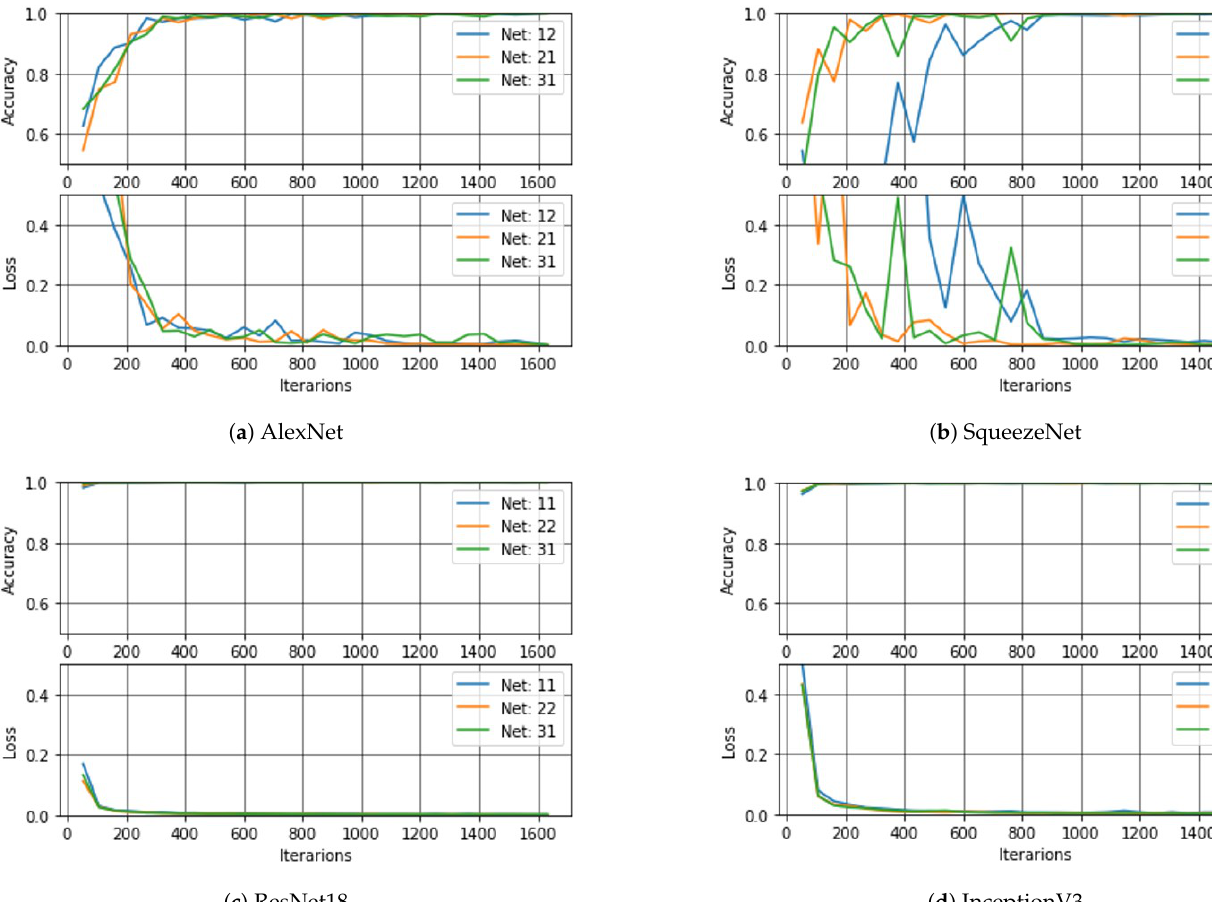
Figure 14. Convergence comparison for different TL-based models. The first index in each network corresponds to the dataset (i.e., 1 = DS1, 2 = DS2, 3 = DS3), while the second index corresponds to the freezing point (i.e., 1 = UF, 2 = MF, 3 =